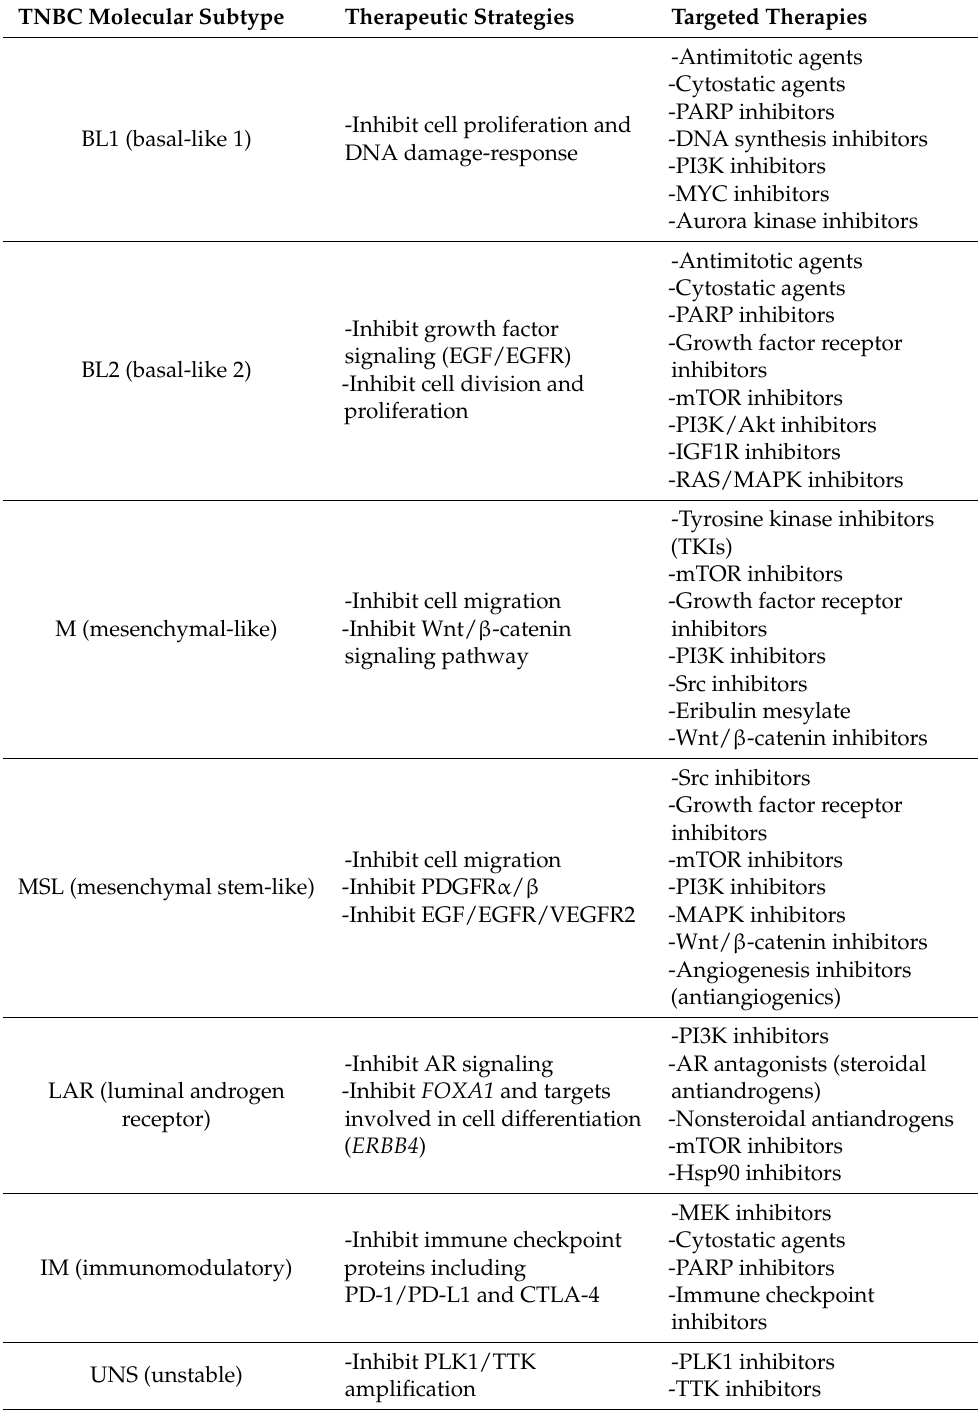
Table 2. Potential targeted drug therapies for the treatment of specific TNBC molecular subtypes